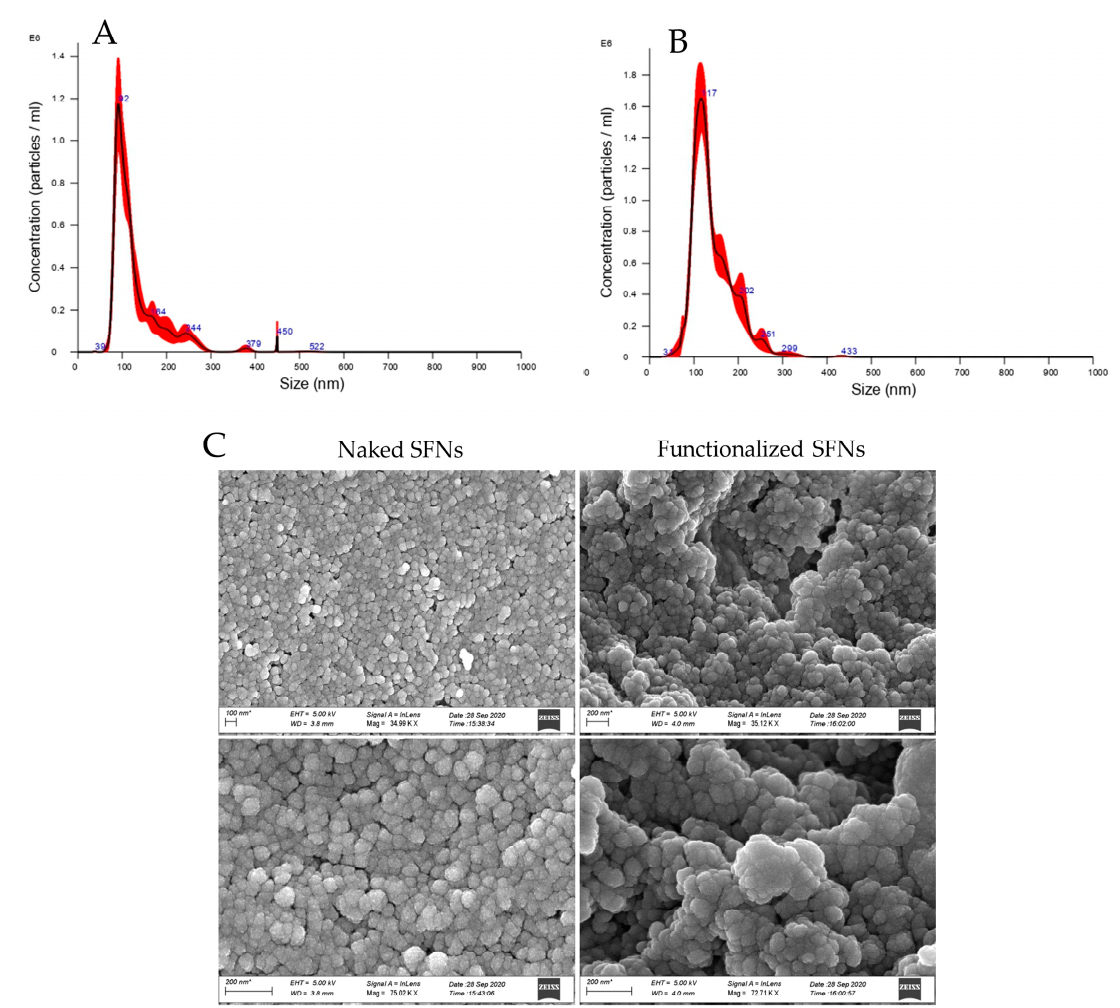
Figure 3. Particle size distribution for naked ( A ) and functionalized ( B ) SFNs, and morphological investigation by SEM ( C ). Scale Bar:100 or 200 nm. Analytical size exclusion chromatography (SEC) was selected to compare the elution profiles of naked and functionalized SFNs due to its ability to elute analytes in order of their molecular size. The SEC profile of solubilized naked SFNs (Figure 4A) reveals a highly broad peak, indicating an extremely heterogeneous protein mixture. Three main protein populations seem to be present, eluting at 5.5 min (blue box), 8.1 min (red box) and 8.8 min (green box). According to the calibration curve, the estimated average MW is 66 kDa for the last eluting peak (8.8 min) and 110 kDa for the peak at 8.1 min. The first eluted peak (5.5 min) retention time falls outside the calibration range, suggesting an MW greater than 700 kDa, these species not being retained by the stationary phase. After functionalization, a significant change in the SEC profile is observed in relative abun- dance (Figure 4B). The peak at 8.1 min decreases in height, while the non-retained peak increases its abundance, suggesting that the functionalization induces the formation of a high-MW protein population. Overall, the increased size of nanoparticles after function- alization and the greater MW suggest proper functionalization of SFNs.